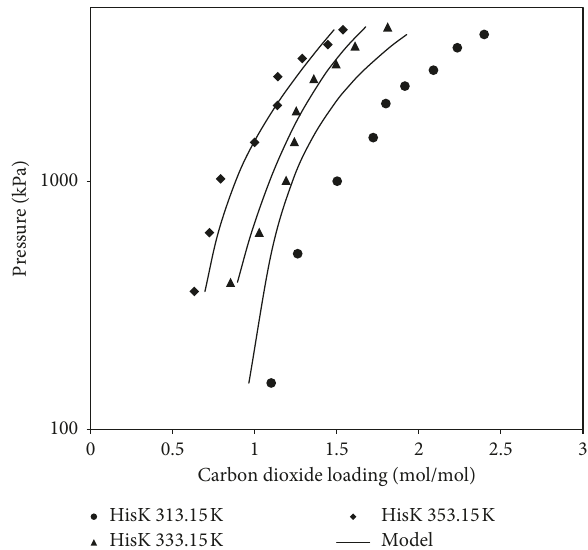
Figure 6: Correlation of modified Kent–Eisenberg model against the experimental solubility of carbon dioxide in 1M aqueous potassium salt of L -histidine